Question: Author a descriptive caption for the visualization shown.
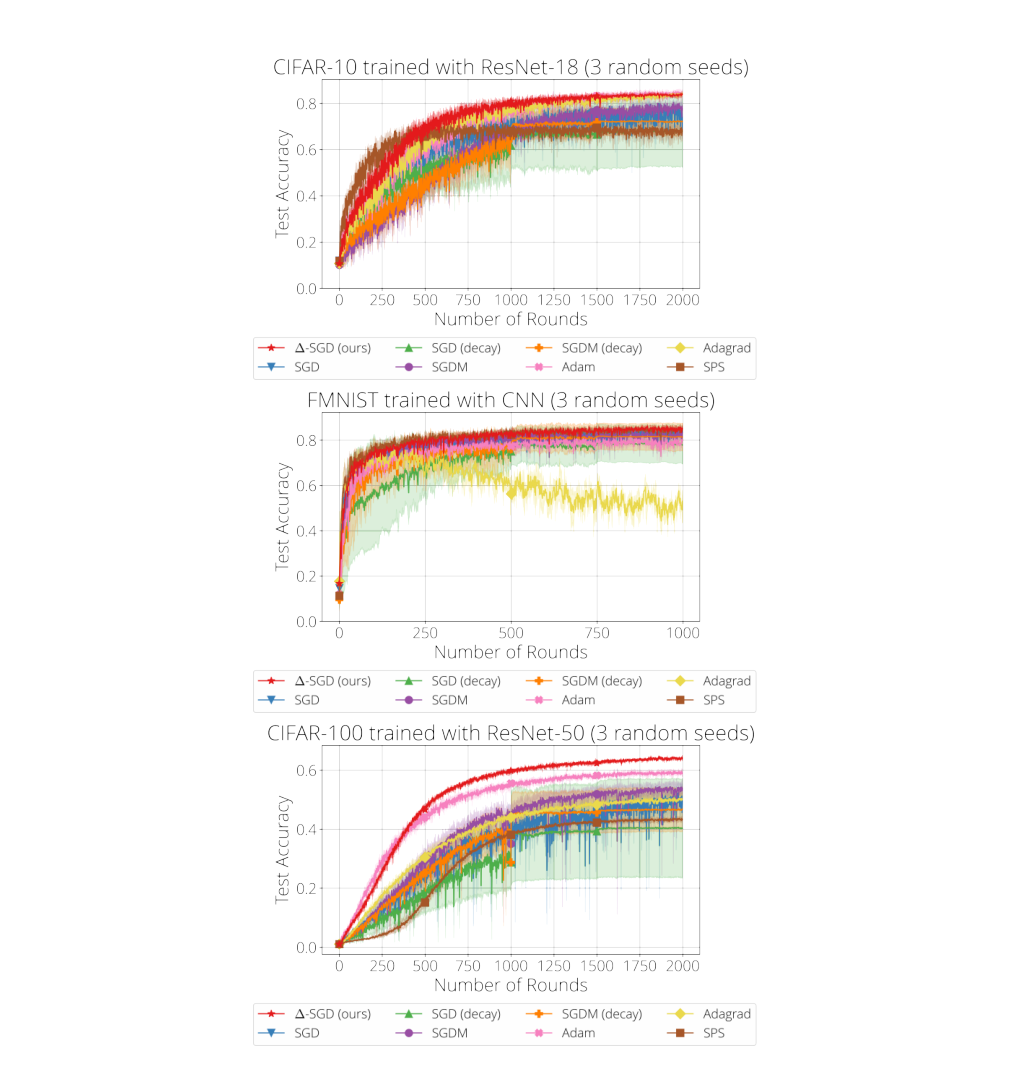
Answer: Additional plots for CIRAR-10 classification trained with a ResNet-18, FMNIST classifica- tion trained with a CNN, and CIFAR-100 classification trained with a ResNet-50, repeated for three independent trials. The average is plotted, with shaded area indicating the standard deviation.